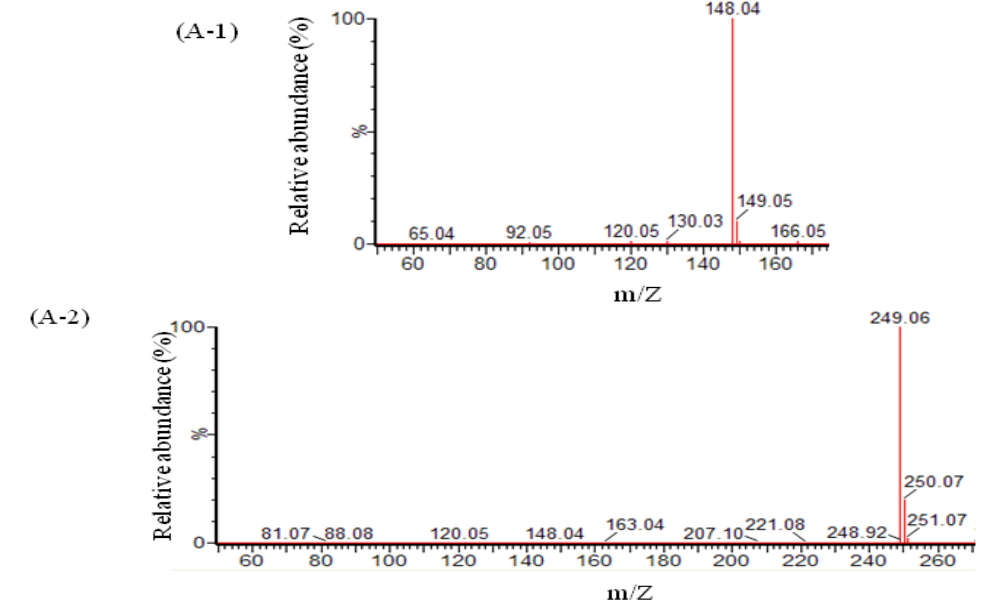
of indigo naturalis and Strobilanthes formosanus Moore. ( A ) APCI-mass spectra of isatin (A-1) and tryptanthrin (A-2) purchased from Sigma-Aldrich Chemicals; ( B ) UPLC chromatogram of the mixture (molar ratio = 1:1) of isatin and tryptanthrin purchased from Sigma-Aldrich Chemical; ( C ) UPLC total ion chromatogram of the EA-extract of indigo naturalis powder (50 µg); ( D ) UPLC total ion chromatogram of the EA-extract of the dry leaves from S. formosanus (50